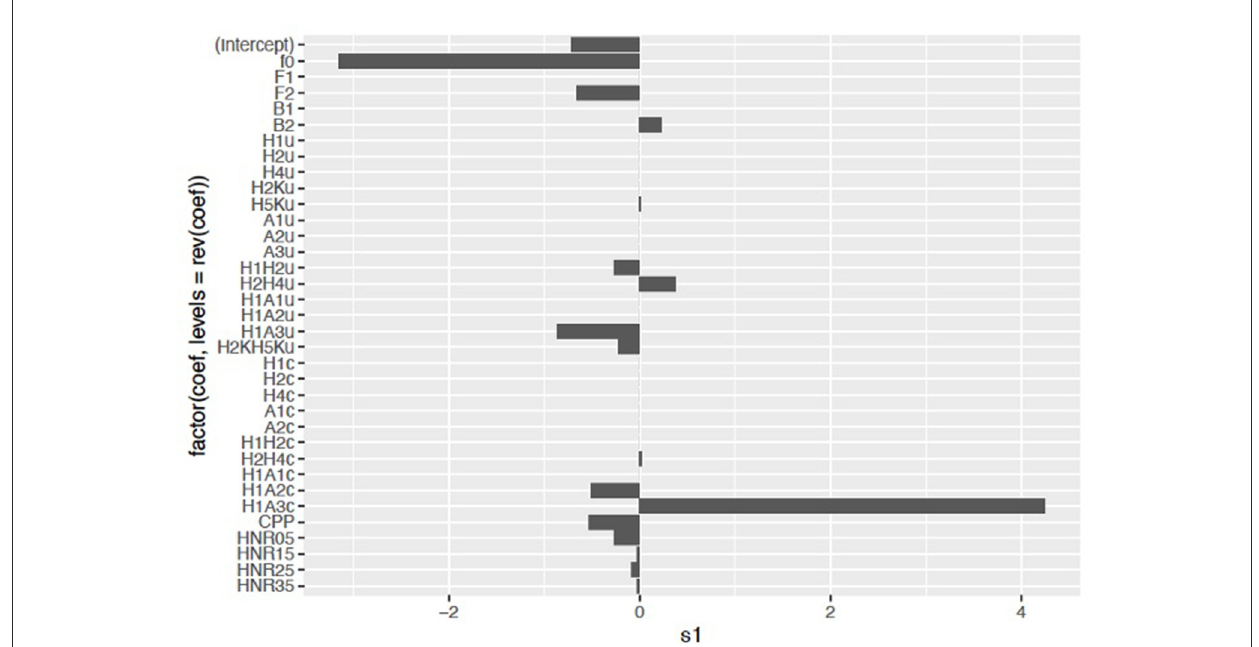
FIGURE6 Factor plot for LASSO regression model of voice quality features by race rating.